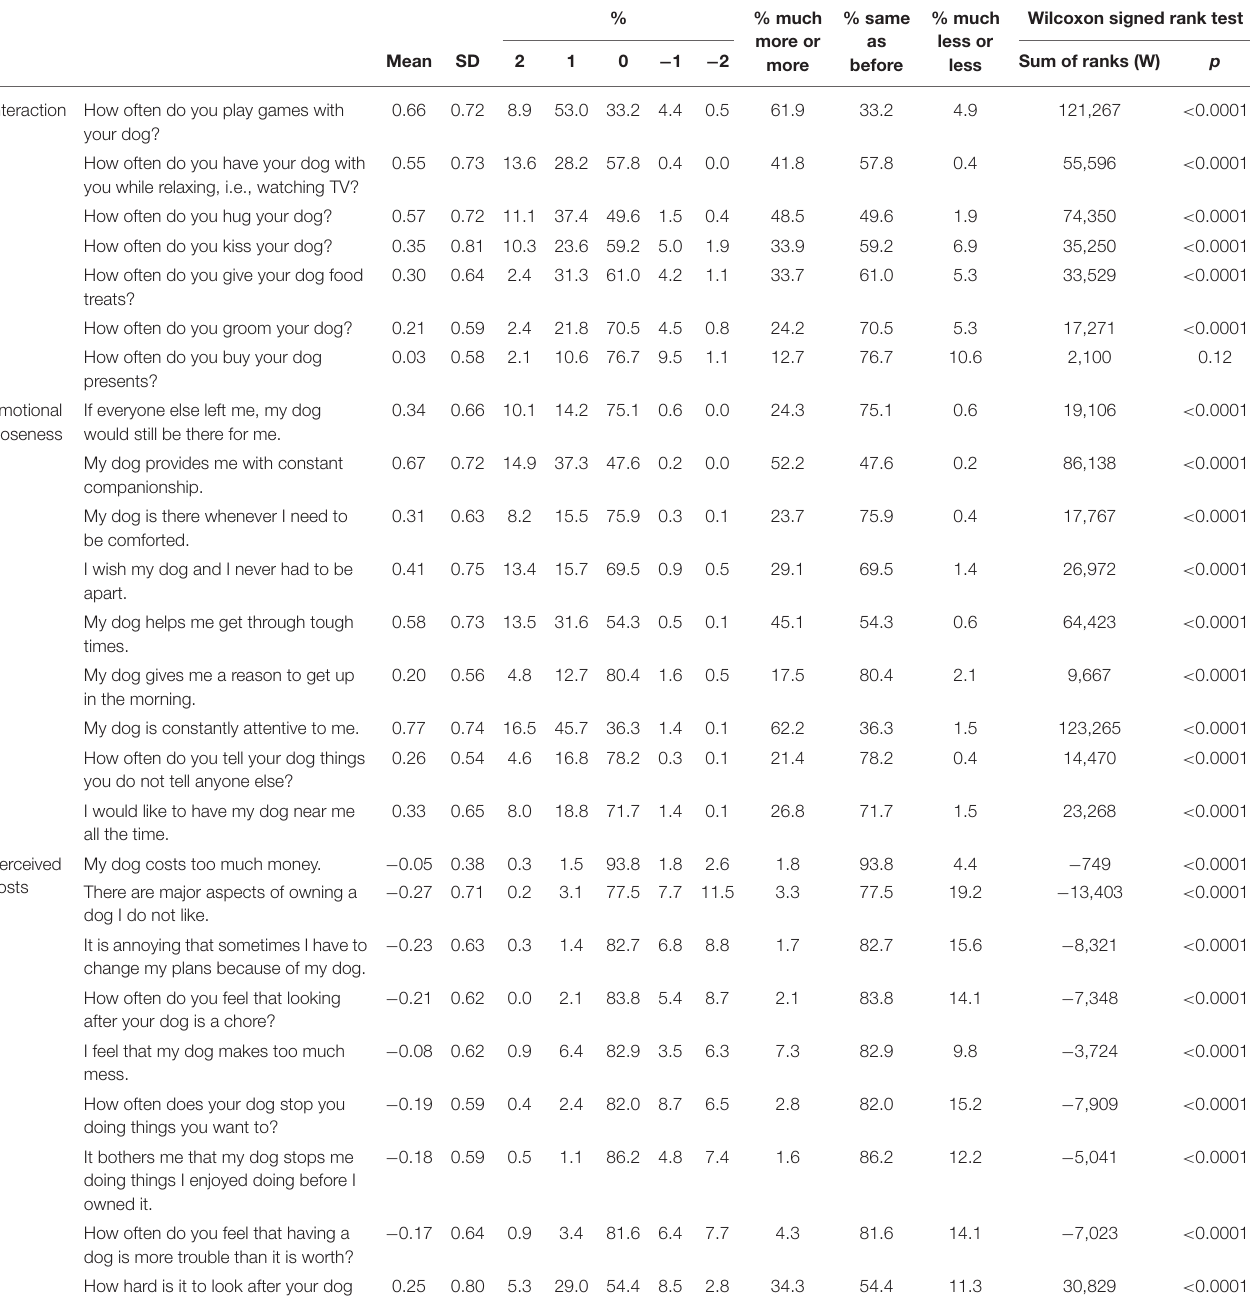
TABLE 3 | Individual item scores for C/DORS items and the results of the single-sample Wilcoxon signed rank test (convenience sample, COVID).